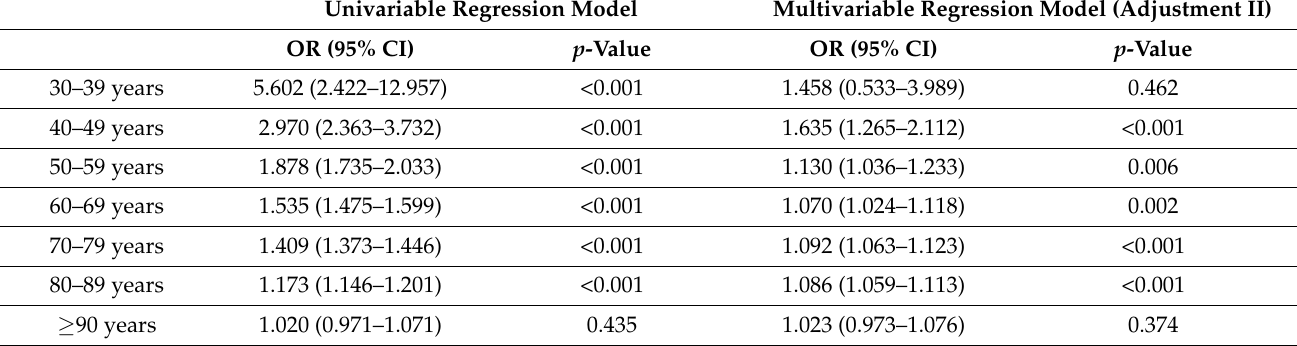
Table 3. Impact of diabetes mellitus on in-hospital death in PAD patients (univariable and multivariable logistic regression